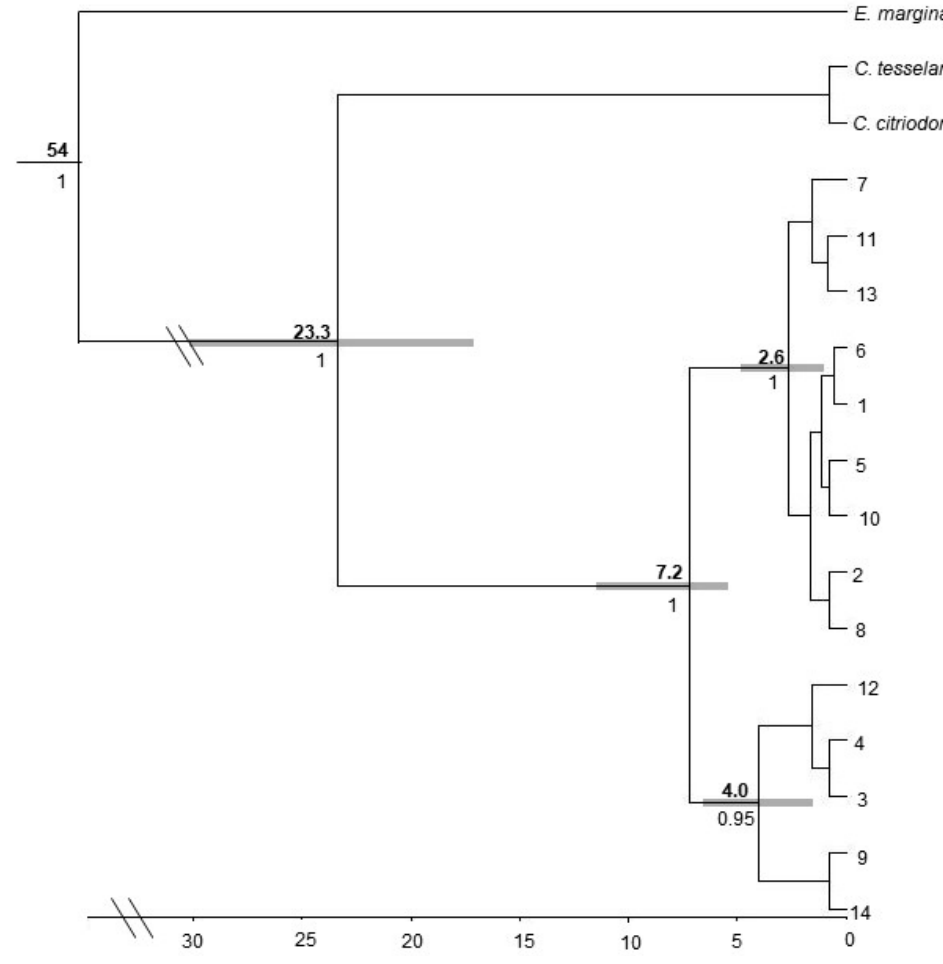
Figure 5. Phylogenetic tree of C. hamersleyana constructed from three cpDNA regions. Bold numbers above nodes indicate age in millions of years, numbers below lines are posterior probabilities of well supported internal nodes. Double slash lines indicate truncation of branch lengths for ease of visualisation. Note the tree shown for C. hamersleyana was dated based on the mean stem age of the Corymbia ( Angophora ) clade [65]. Grey boxes represent 95% confidence intervals (HPD). Scale bar represents time (Ma).